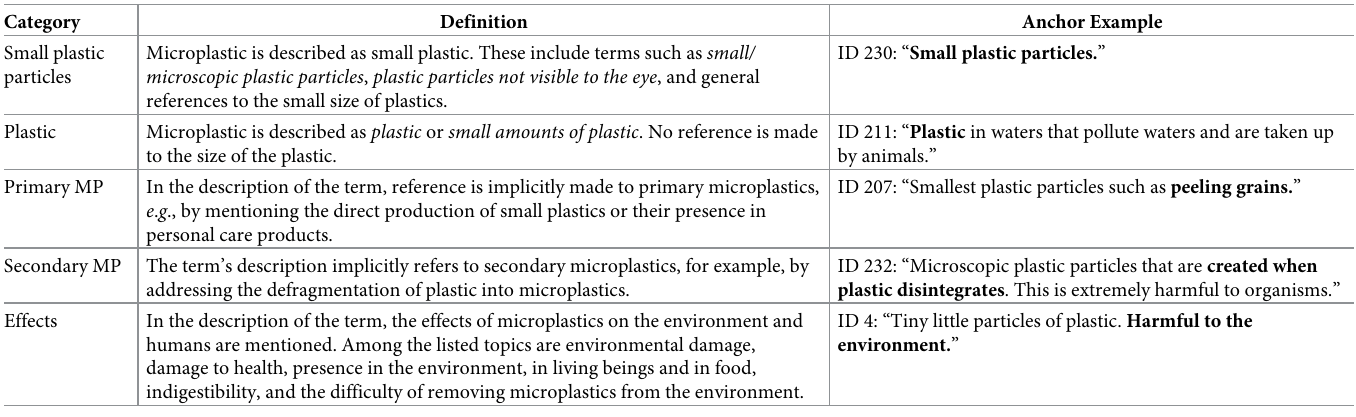
Table 3. Exemplary coding guideline of